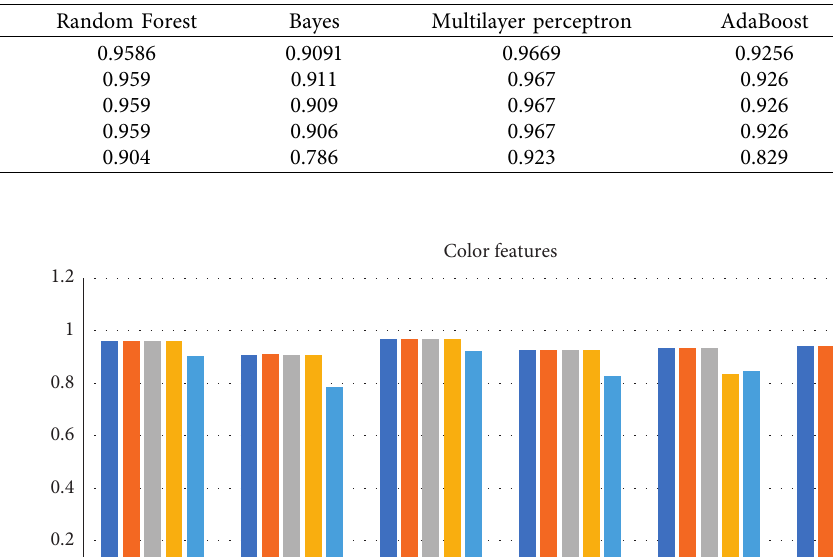
Figure 13: Classifier evaluation based on 8 features. Table 5: Classification accuracy based on color feature extraction.